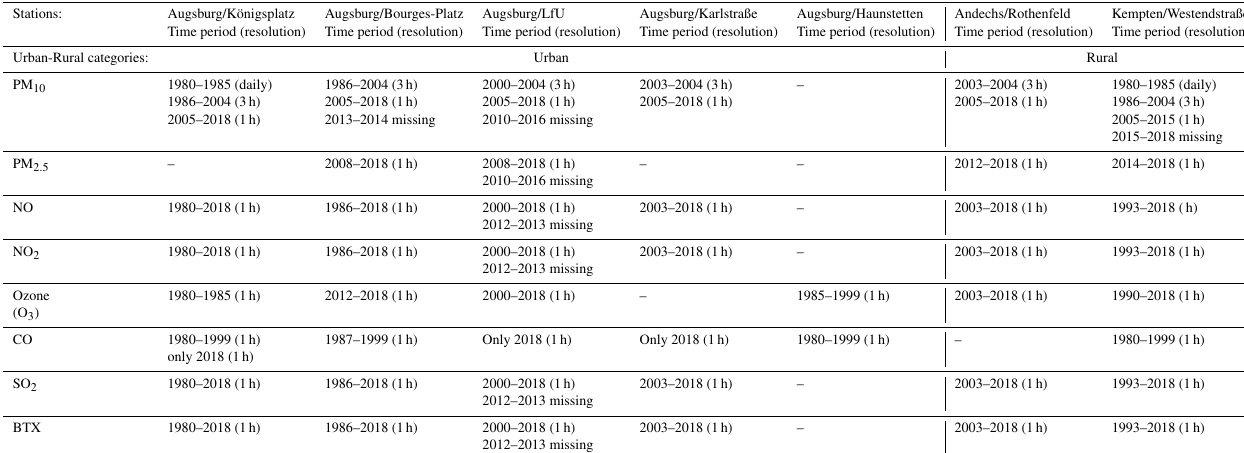
Table A1. Air quality stations data availability and